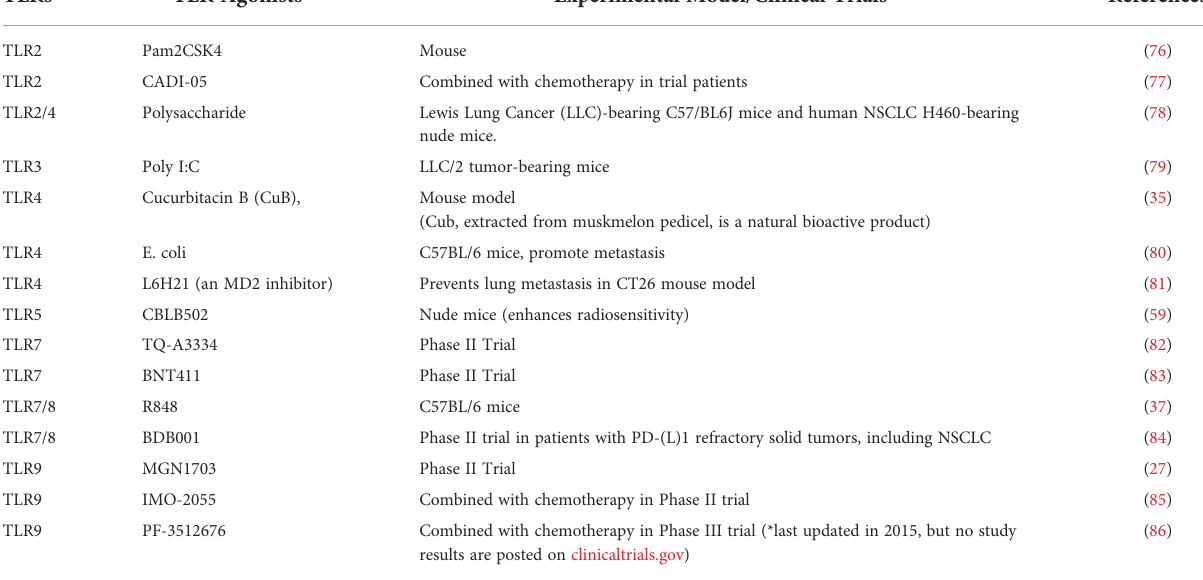
TABLE 2 Use of TLR agonists for lung cancer